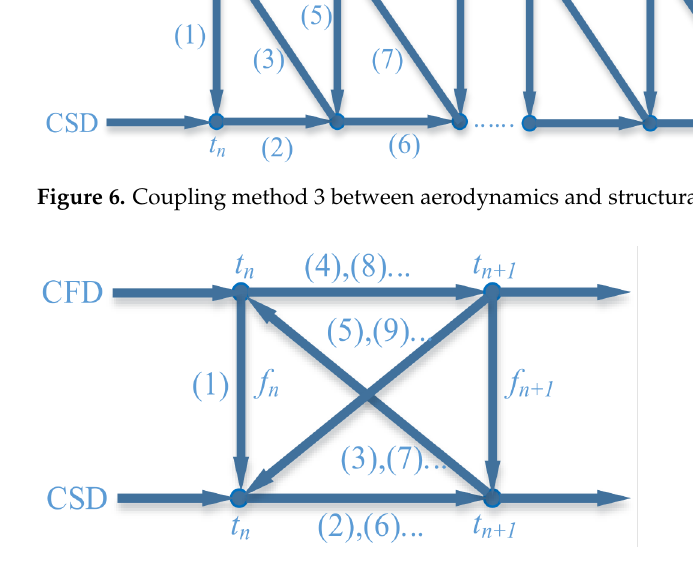
Figure 7. Coupling method between aerodynamics and structural